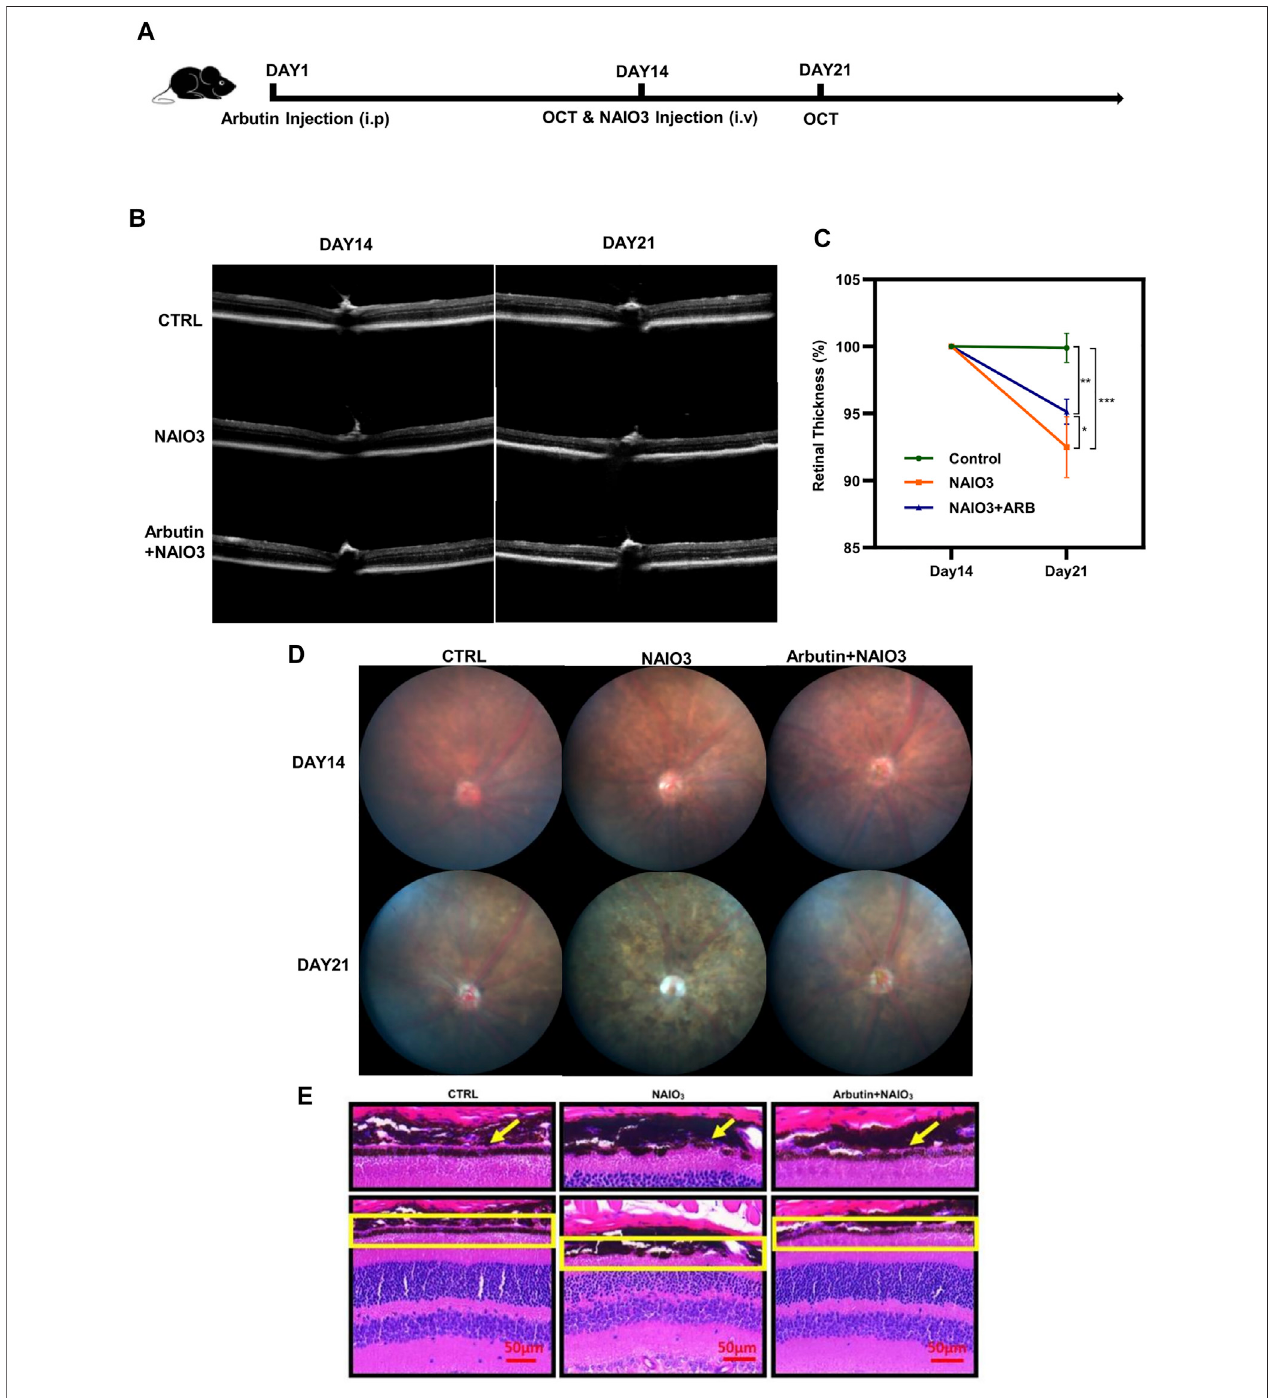
FIGURE 6 | Arbutin attenuated NAIO 3 -induced retinal thickness loss in C57BL/6J mice. (A) experimental procedure: The experiments were based on wild-type C57/BL6 mice. (B) the images of retinas were taken by optical coherence tomography examination at the timepoints of days 14 and 21. (C) the retinal thickness difference of mice with different treatments is shown in the charts. (D) fundus imaging of mice in different groups. (E) H & E staining showed retinal sections of mice treated with different treatments (* p < 0.05, ** p < 0.01, *** p < 0.001, n = 3, bars represent SD).